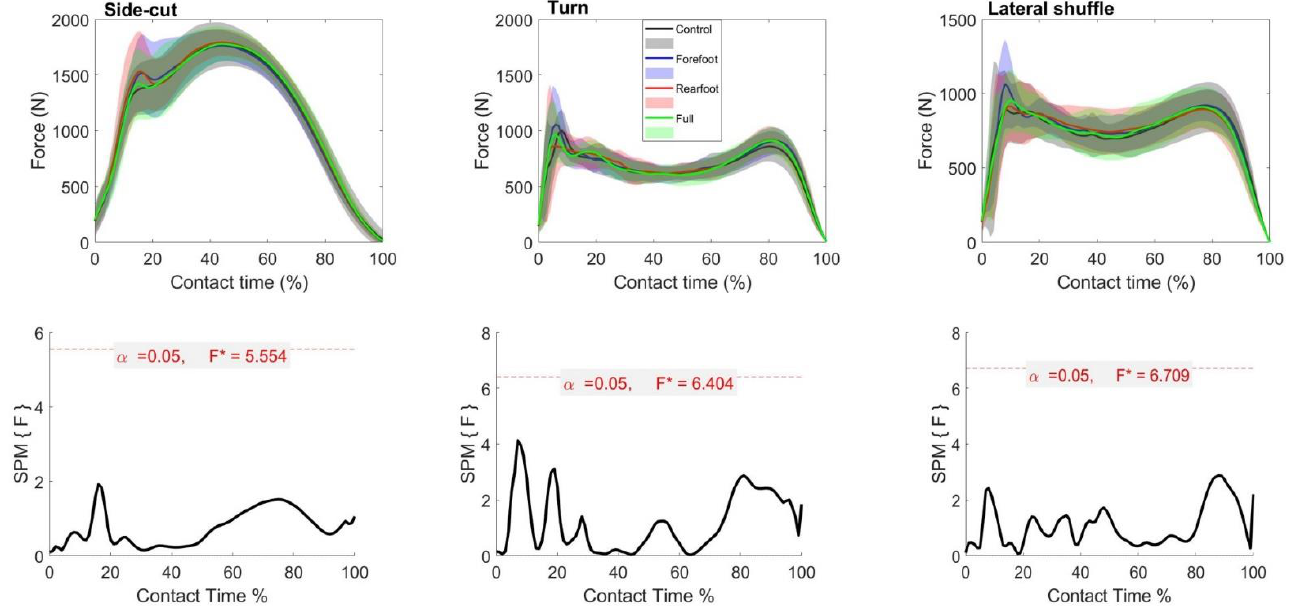
Figure 3. Mean (SD) vertical ground reaction force results across participants for each shoe condition (Black = Control, Blue = Forefoot, Red = Rearfoot; Green = Full) ( top ). The SPM(F) values across ground contact time ( bottom ). F* = critical value